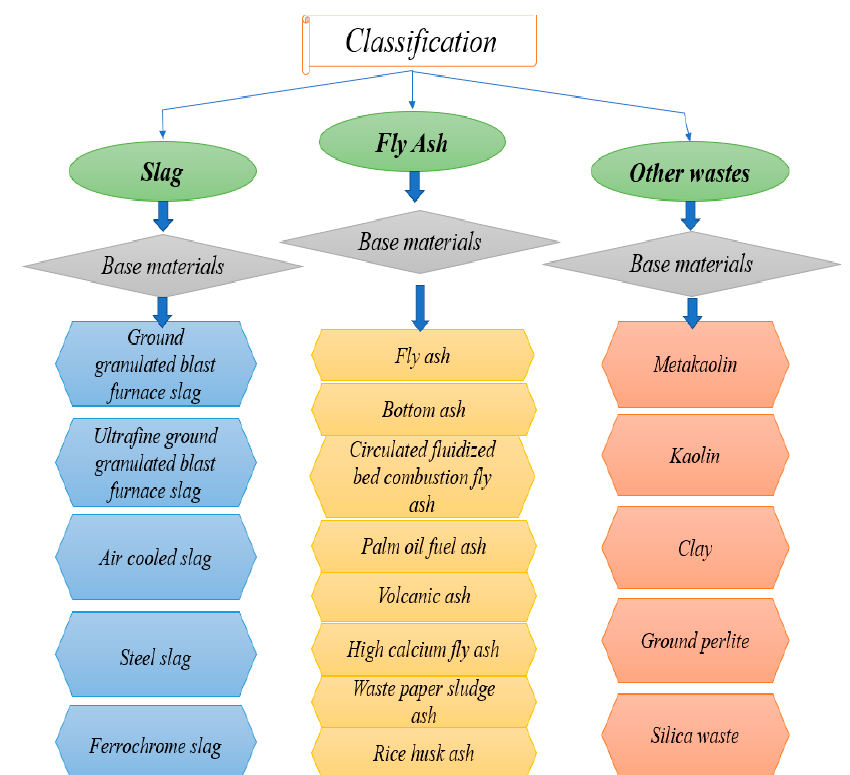
Figure 3. Raw materials used in geopolymer